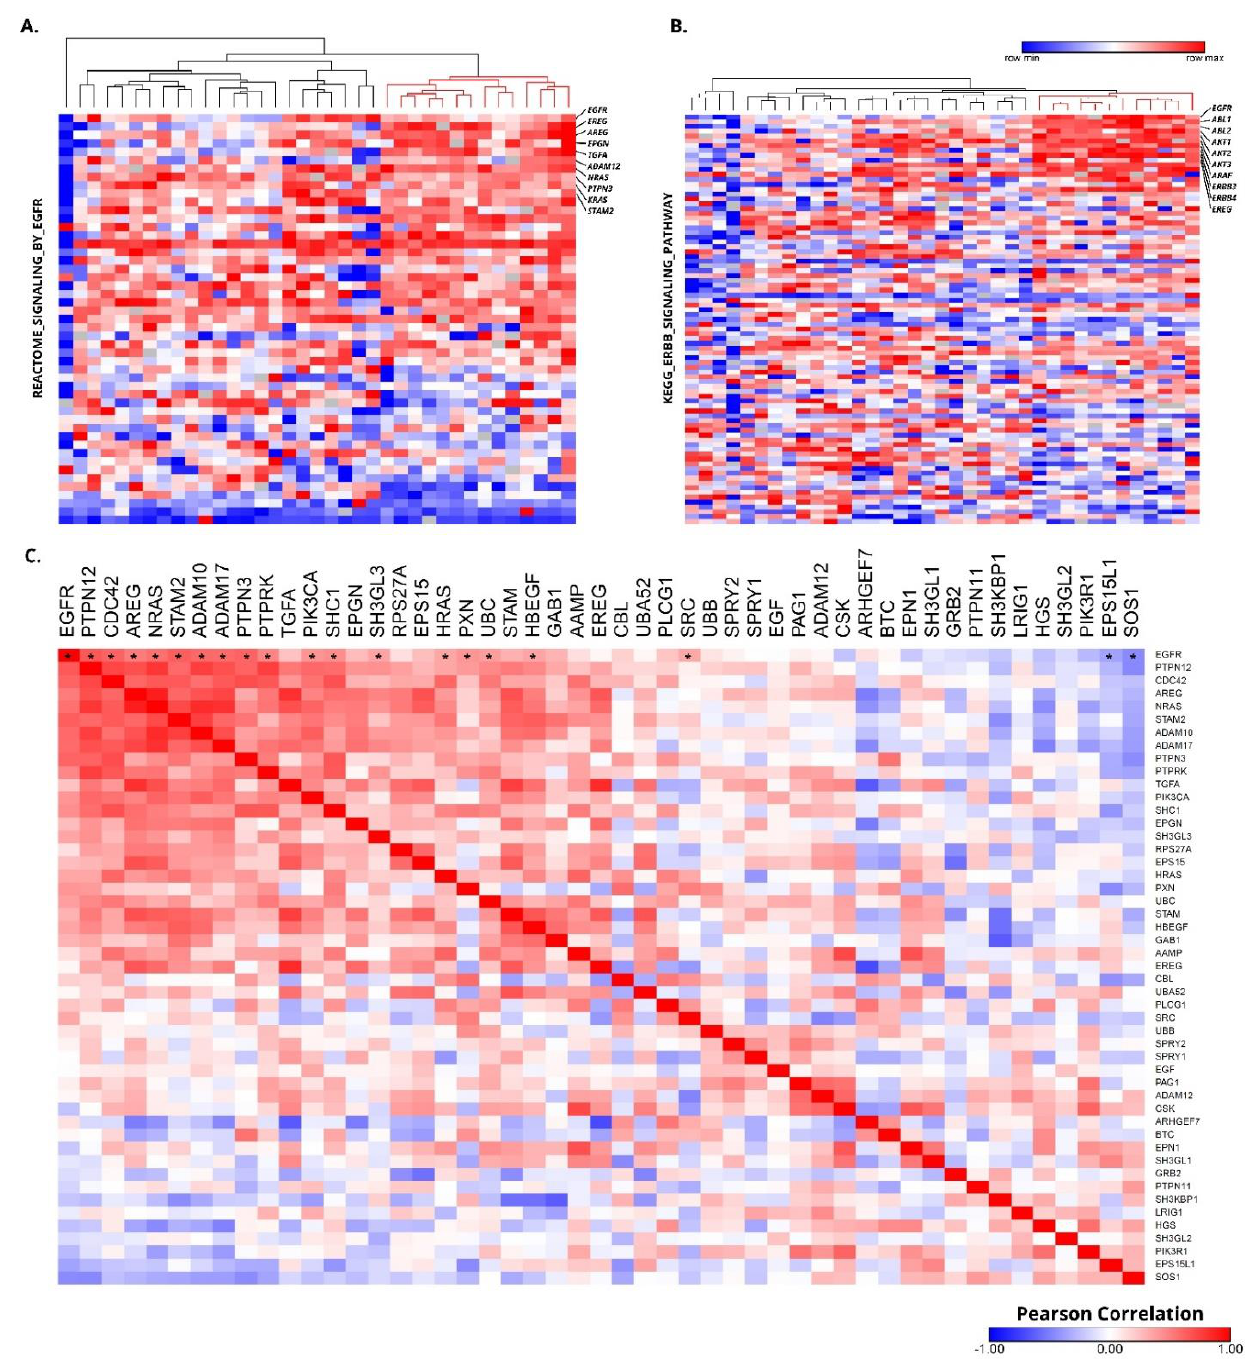
Figure 5. Approximately 30% of penile cancer overexpresses genes related to the EGFR signaling pathway. Heatmap illustrating the Reactome signaling by EGFR (50 genes) ( A ) and KEGG ERBB signaling pathway (87 genes) ( B ) signature of 36 PeCa samples (GSE57955). Rows represent normalized mRNA expression for a single gene (Agilent microarray, Agilent, Santa Clara, CA, USA), and each column represents one of the 36 previously analyzed PeCa samples. All tumor samples were normalized with a pool of normal samples, and the values were ranked by their expression levels (blue: down-expressed genes, red: overexpressed genes). The red cluster ( A , B ) presents overexpression of several genes belonging to the EGFR signature. ( C ) Heatmap representing a matrix of the Pearson correlation of genes from the Reactome signaling by EGFR in the 36 PeCa samples (GSE57955). EGFR (first column) was positively correlated with several genes of the PIK3 and MAPK pathways. A significant P-value of Pearson correlation is represented by (*) only for the EGFR gene (first line).